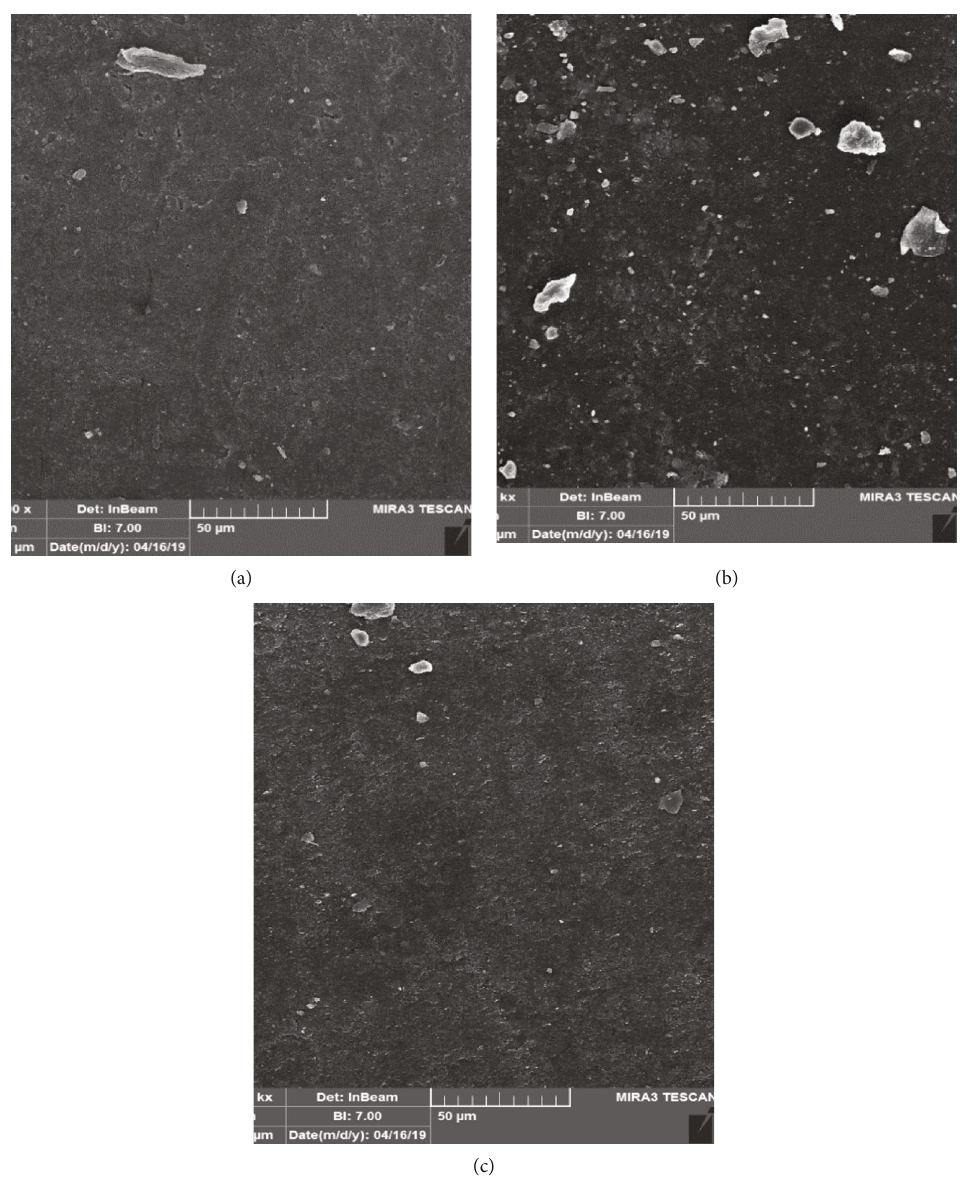
Figure 16: SEM image: (a) S70N30 sample, (b) S70N30C3 sample, and (c) S70N30C5